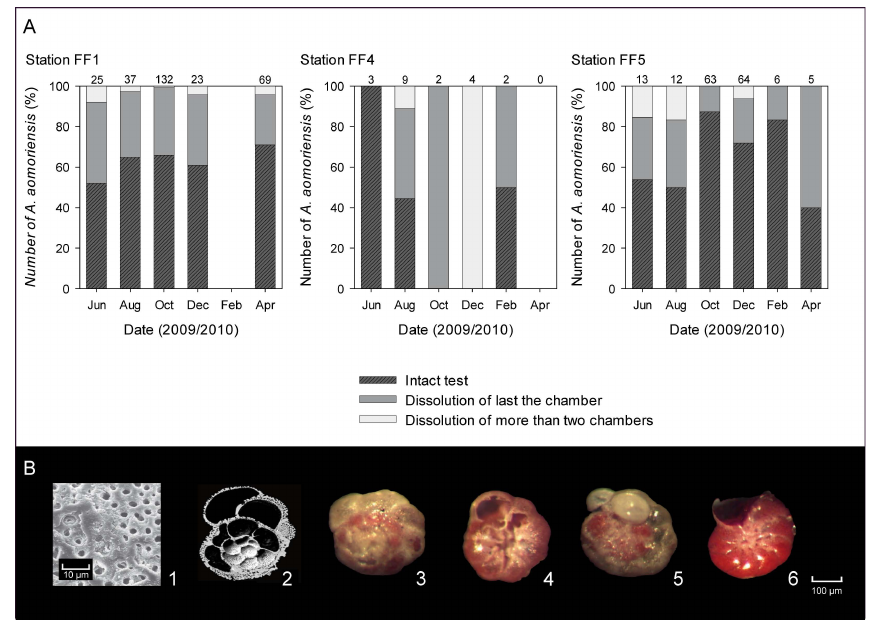
Fig. 7. (A) : Three stages of preservation of living A. aomoriensis : intact tests, dissolution of the last chamber and dissolution of more than two chambers. Bars indicate the percentage of total species number of A. aomoriensis (Table 5) from June 2009 to April 2010. The number of counted A. aomoriensis specimens is present above each bar. (B) : Subjacent SEM (1), EPMA (2) and light micrographs (3–6) of A. aomoriensis and E. incertum tests from Flensburg Fjord from Station FF5 in June 2009. 1–5 A. aomoriensis : detailed view of irregular test shape (1), spiral (2, 3 and 5) and umbilical (4) views of recalcifying (2 and 3) and dissolved tests (4 and 5). 6 spiral view of E. incertum with intact test, last chamber was